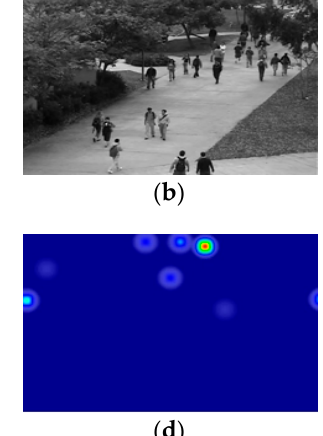
Figure 9. The comparison of MAE with seven methods in five different scenes.